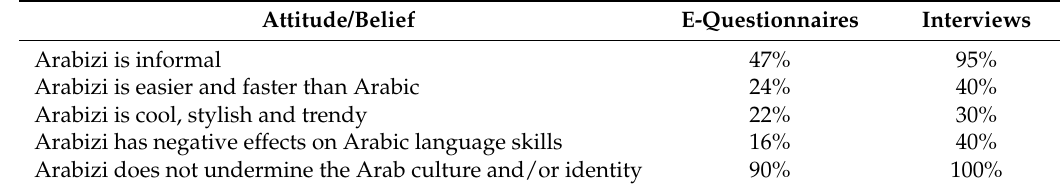
Table 1. The users’ beliefs about